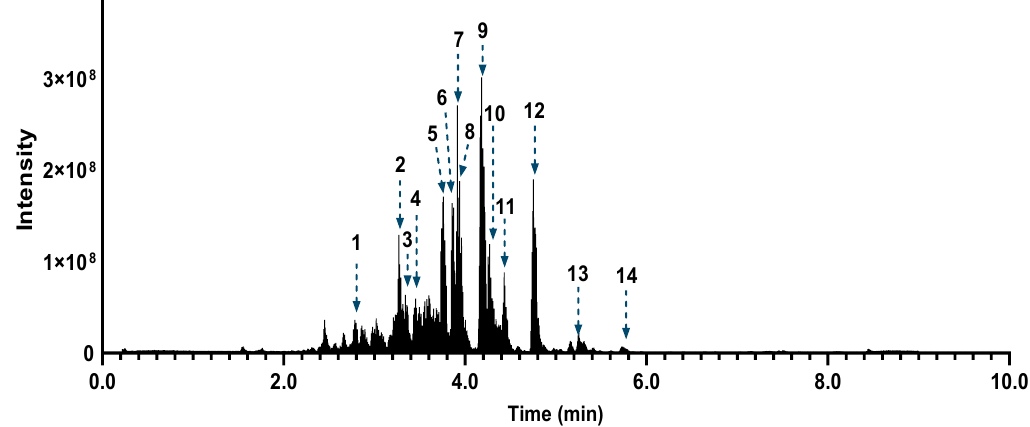
Figure 6. Total ion current chromatographic trace (ESI negative) showing the 14 putatively identified compounds in the ethyl acetate extract of Azorella atacamensis ( Aa E).